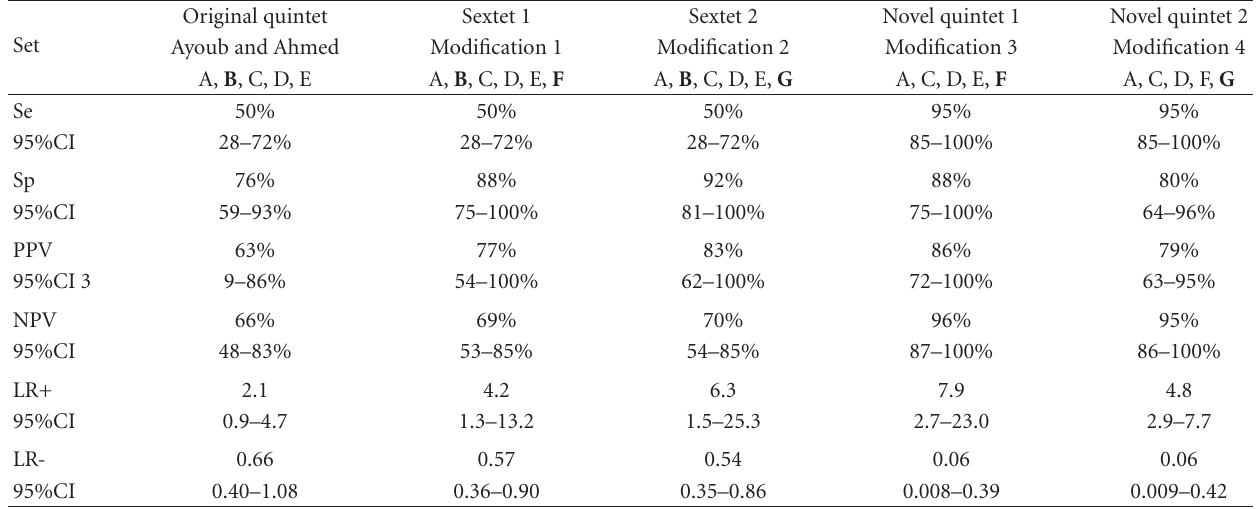
Table 2: Test characteristics of three sets applied as diagnostic criteria in 45 patients consisting of 36 patients with definite post-streptococcal reactive arthritis (PSRA) due to group A streptococci (GAS: n = 20) and due to nongroup A streptococci (NGAS: n = 16), and 9 non-PSRA patients: calculations represent values of a screening test aiming to find GAS-related PSRA only. Legend: Sensitivity (Se); Specificity (Sp); Positive Predictive Value (PPV); Negative Predictive Value (NPV); Likelihood ratio (LR+) in an ideal test is optimal when ad infinitum, as it gives a ratio between probability on a positive test result in GAS-induced PSRA patients versus nonindex patients; Likelihood ratio negative test (LR − ) in an ideal test is optimal when it reaches nil, as it gives a ratio between probability on a negative test result in GAS-induced PSRA versus nonindex patients. In the second line 95% confidence intervals (95%CI) are given. For criteria (A), (B), (C), and so forth see also text in Materials and Methods